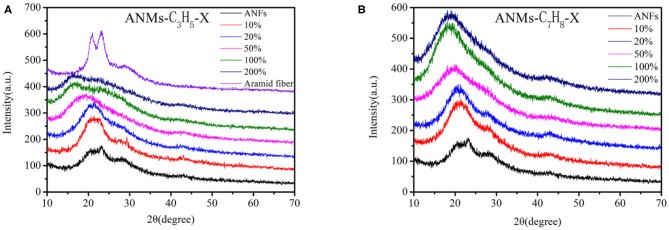
XRD spectra of ANMs-C3H5-X (A) and ANMs-C7H8-X (B) samples.